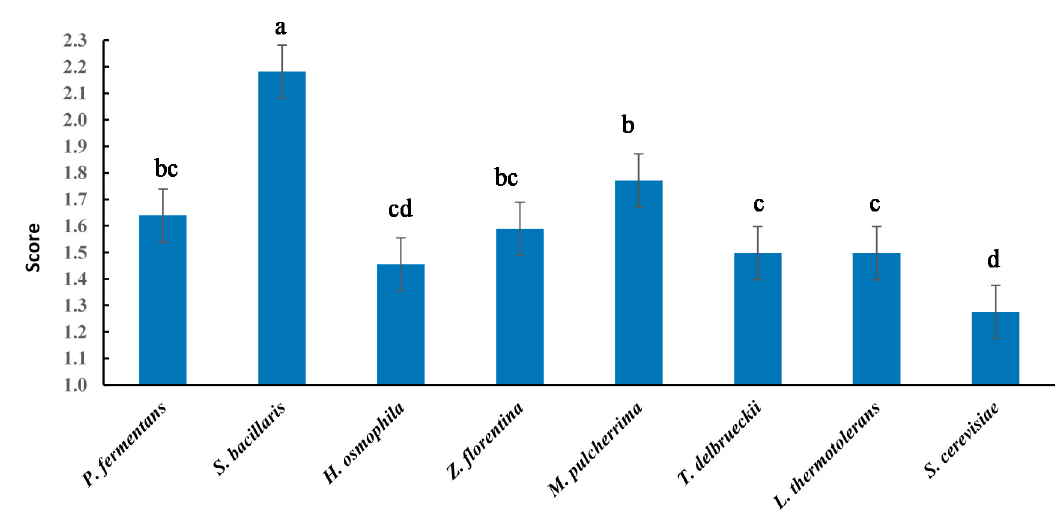
Figure 5. Sensory perception of color in wines 4 months after bottling (QDA score: scale 1–4). Values displaying different letters (a, b, c, d) are significantly different according to the Duncan test ( p ≤ 0.001).